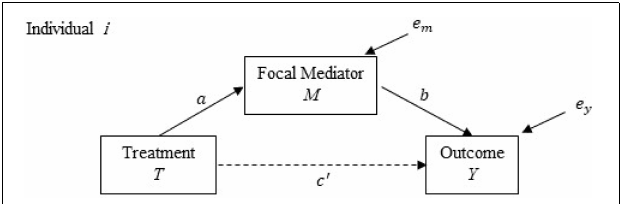
FIGURE 1 | Model with only focal mediator. Path diagram for conventional mediation analysis with only focal